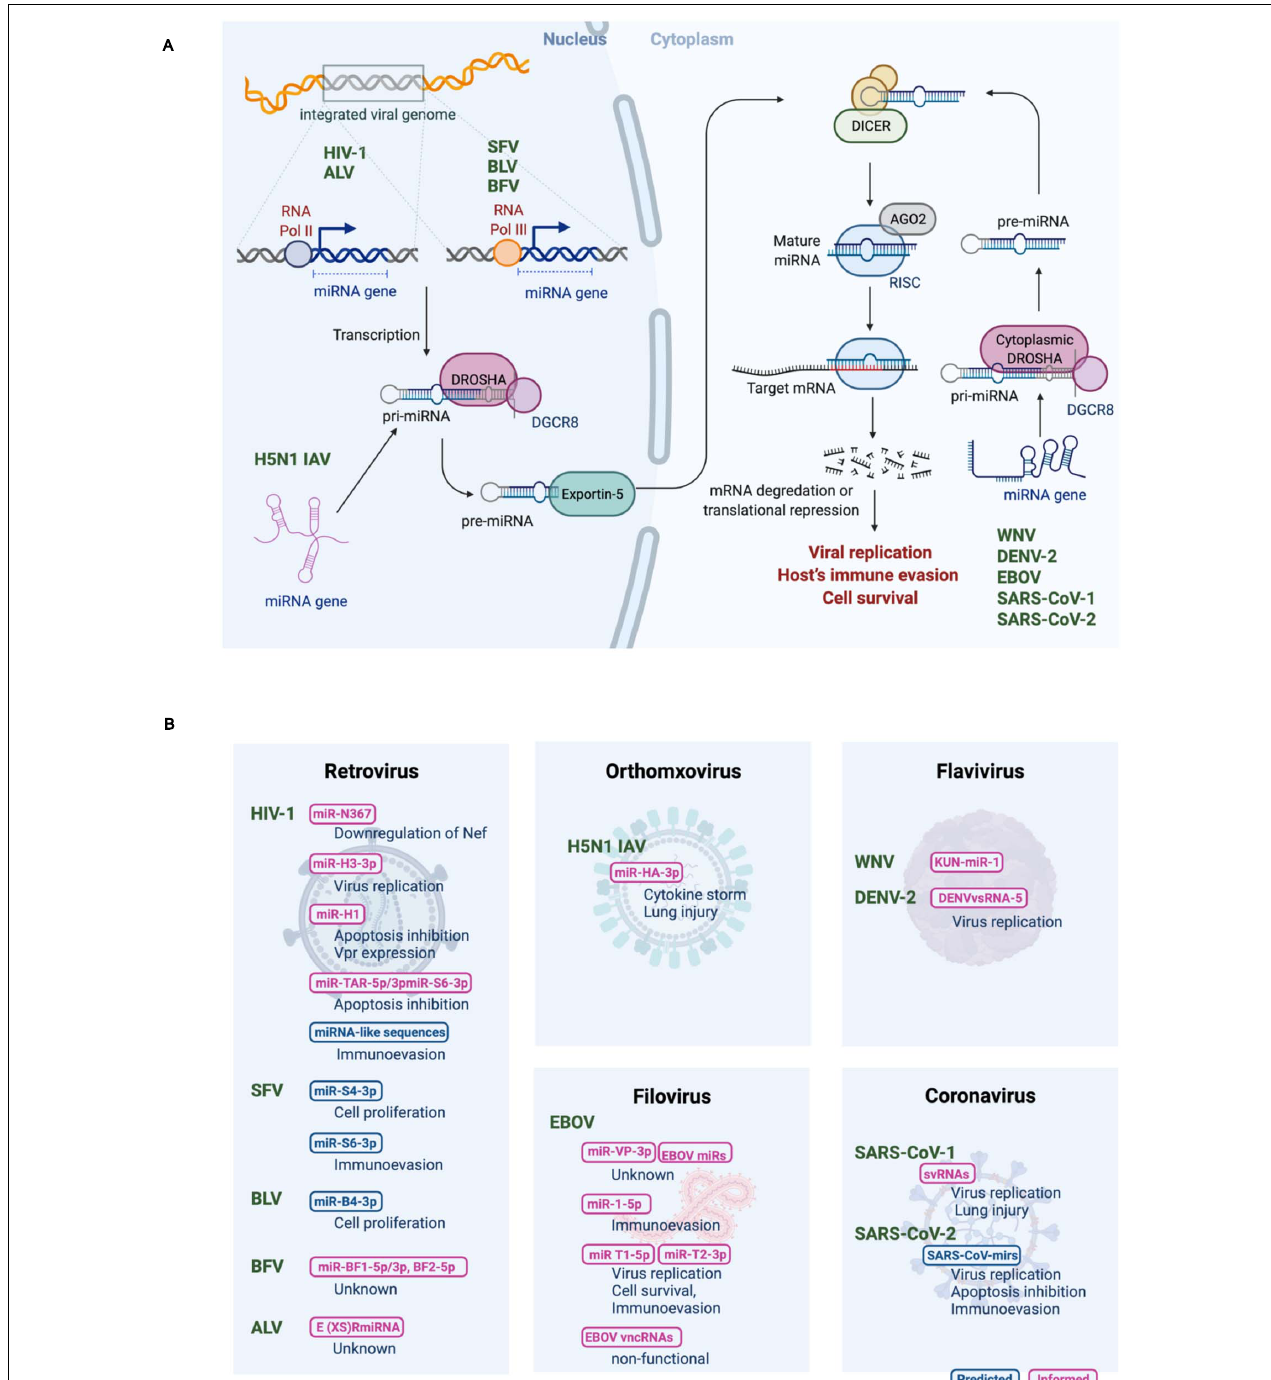
FIGURE 1 | (A) Biogenesis of RNA virus encoded micro RNAs (rv-miRNAs). Canonical miRNAs are transcribed by RNA polymerase II (Pol II) as pri-miRNAs from either the protein-coding region or the non-coding region of the viral genome in the nucleus. Viral genomes of the retroviruses are reverse transcribed into DNA, which is then integrated into a host genome. While transcription of rv-miRNAs encoded by human immunodeficiency virus-1 (HIV-1), and avian leukosis virus (ALV) is mediated by Pol II, rv-miRNAs encoded by simian foamy virus (SFV), bovine leukemia virus (BLV) and bovine foamy virus (BFV) are transcribed by RNA polymerase III (Pol III). Viral RNA genome of influenza A virus (IAV) of the H5N1 subtype replicates in the nucleus. Cleavage of pri-miRNAs by Drosha results in pre-miRNA that is exported to the cytoplasm via exportin 5. In the cytoplasm, pre-miRNAs undergo cleavage by Dicer to generate the mature miRNAs that are loaded in the multiprotein RISC complex to target the host mRNA transcript. The mature rv-miRNAs of west Nile virus (WNV), dengue virus 2 (DENV-2), Ebola virus (EBOV), and